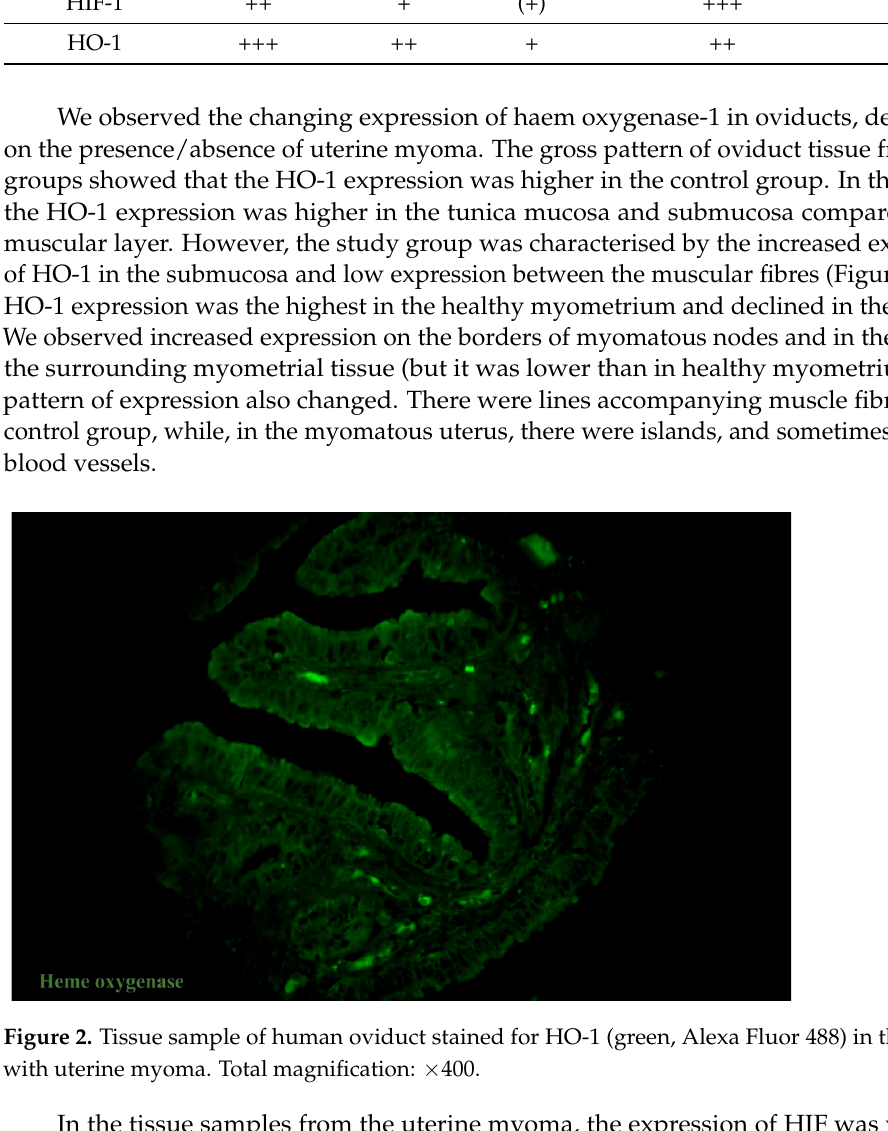
Table 1. Relative frequencies of observed angiogenic markers in the myometrial and oviductal tissue from the study and control groups. 0 = absence; (+) = very few; + = few; ++ = moderate density; +++ = multiple density.